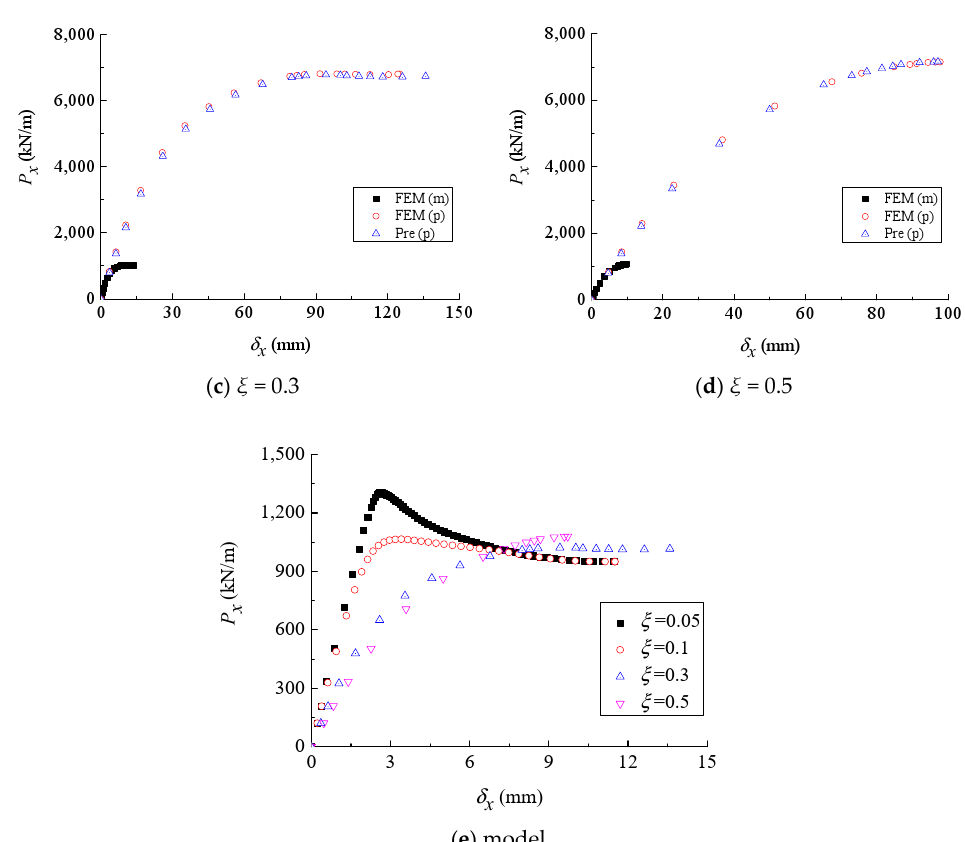
Figure 6. Comparison of the predicted and original load vs. end-shortening curves of the stiffened cylinders with L / R = 2.51 and the SS3 boundary condition when the model material is brass.